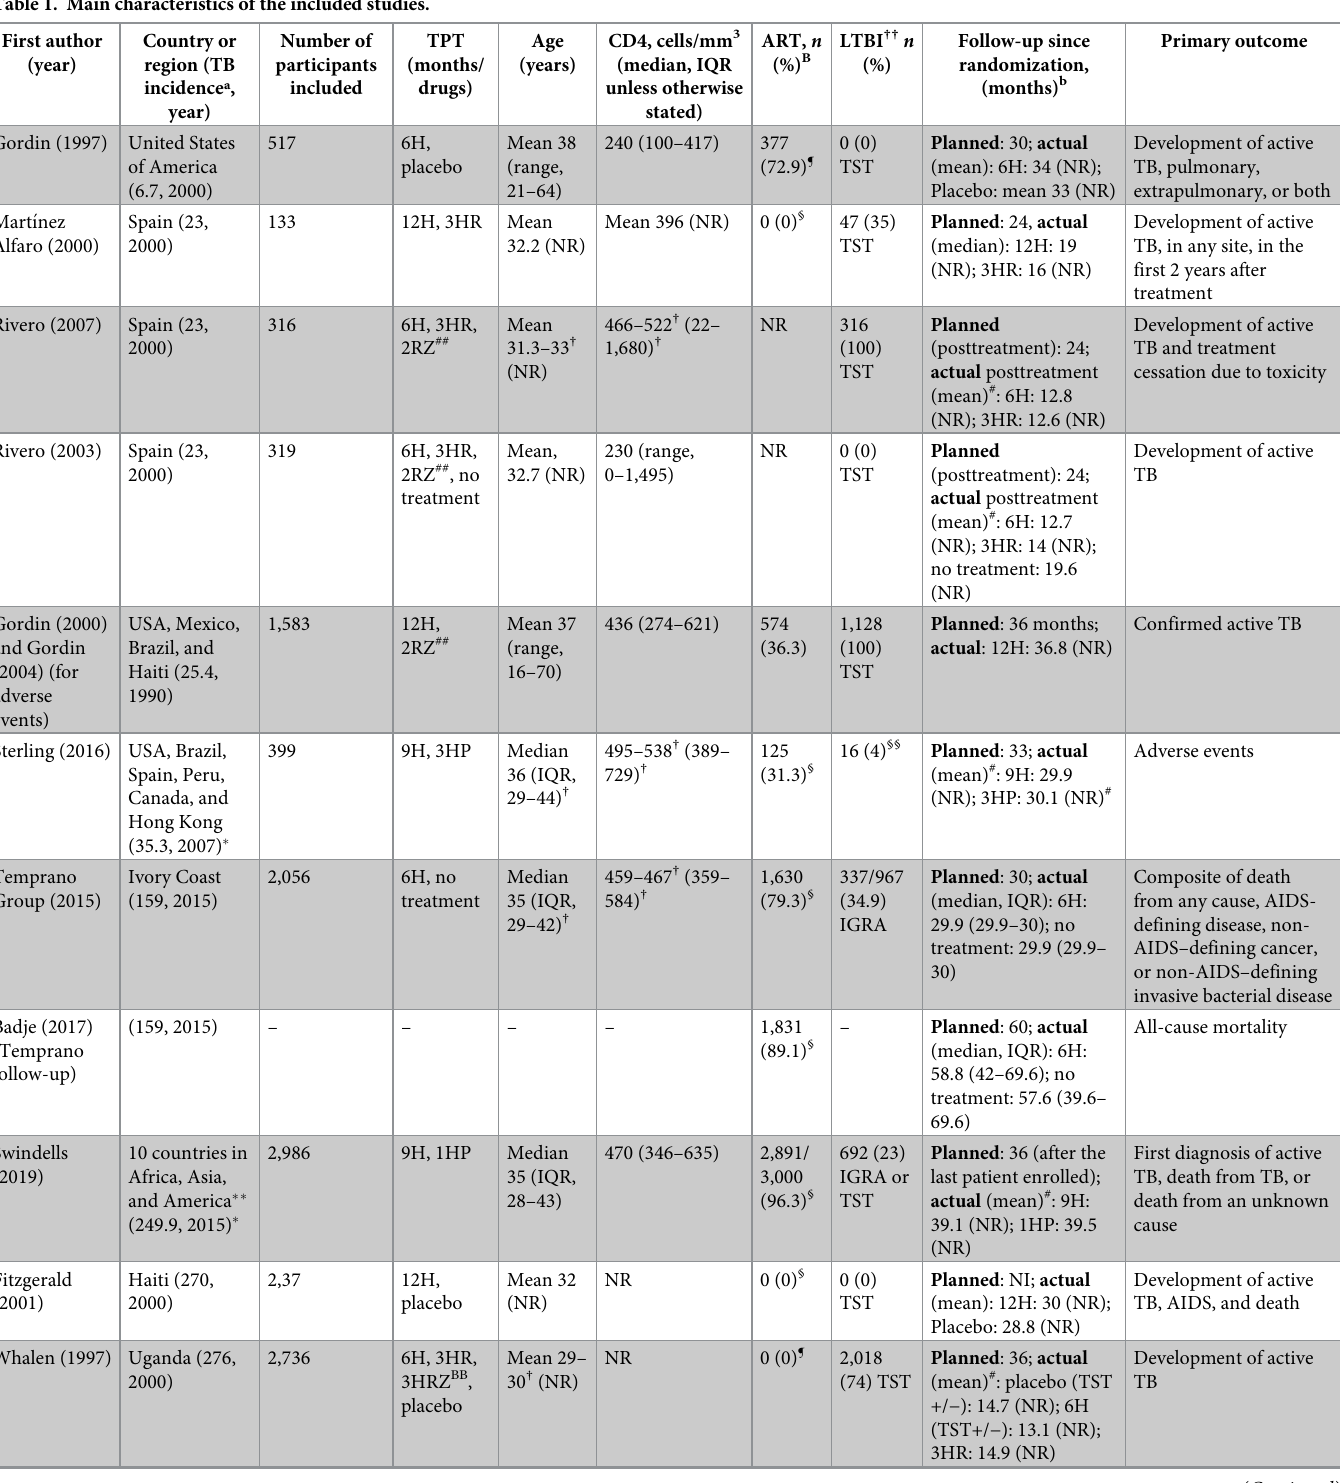
Table 1. Main characteristics of the included